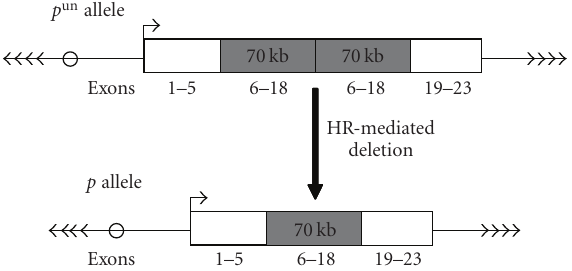
Figure 1: HR-mediated reversion of the p un allele. Schematic of the p un mutation (tandem duplication of exons 6–18), where an HR event mediates the deletion of one copy rendering a functional p gene allowing pigmentation of RPE cells. Circles and arrowheads represent centromere and telomere DNA,